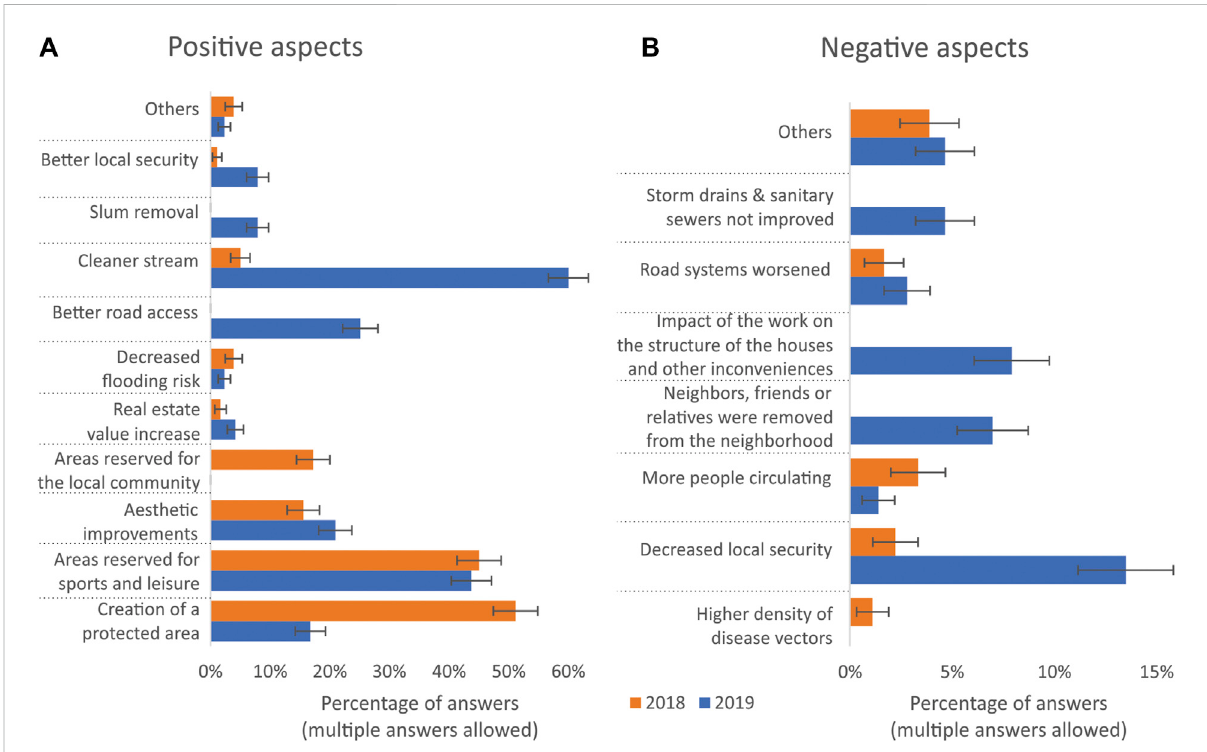
FIGURE 7 (A) Positiveand (B) negativeaspectsregardingrehabilitationmeasuresin2008and2019.Barsaremeans;whiskersare95%con fi